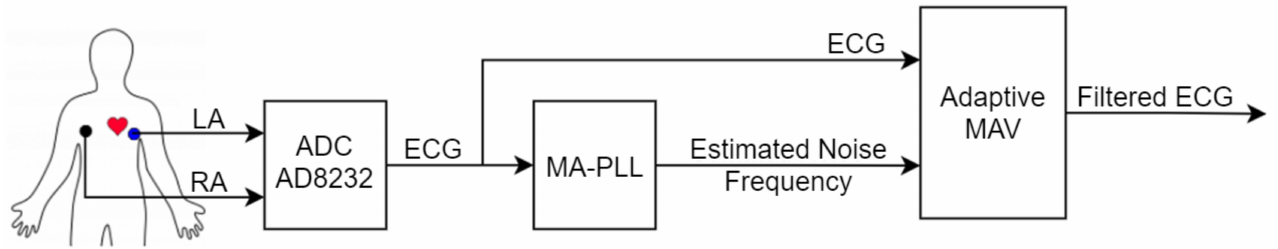
Figure 2. Generalized block diagram of the proposed system.